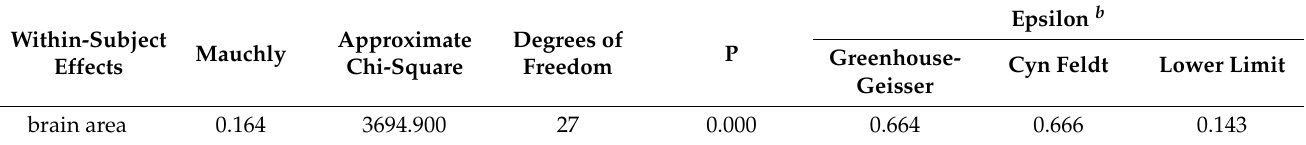
Table 6. Mauchly sphericity